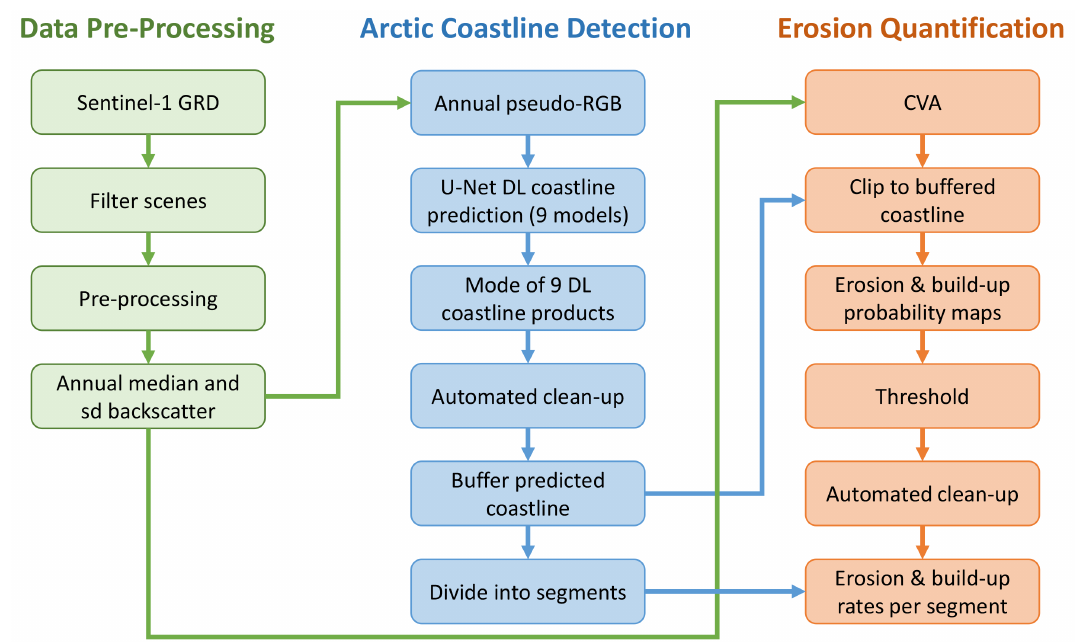
Figure 3. Flowchart of the study outline. The analysis was divided into three parts. In the first part, annual Sentinel-1 (S1) composites were computed. In the second part, a high-quality Arctic coastline product was generated via DL. The third part was dedicated to quantifying Arctic coastal erosion and build-up rates by using the previously computed coastline product as a reference. The following abbreviations are used throughout the info-graphic: Ground Range Detected (GRD); standard deviation (sd); Red Green Blue (RGB); DL; and